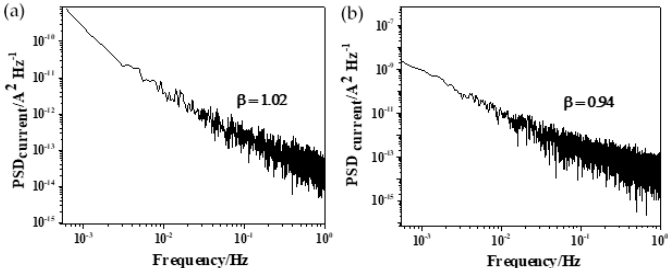
Figure 7. PSD plot (A 2 / f) of current noise signal vs frequency (Hz) for AA6061-T6 after 30 days of exposure to seawater: ( a ) with laminar and ( b ) stationary flows.